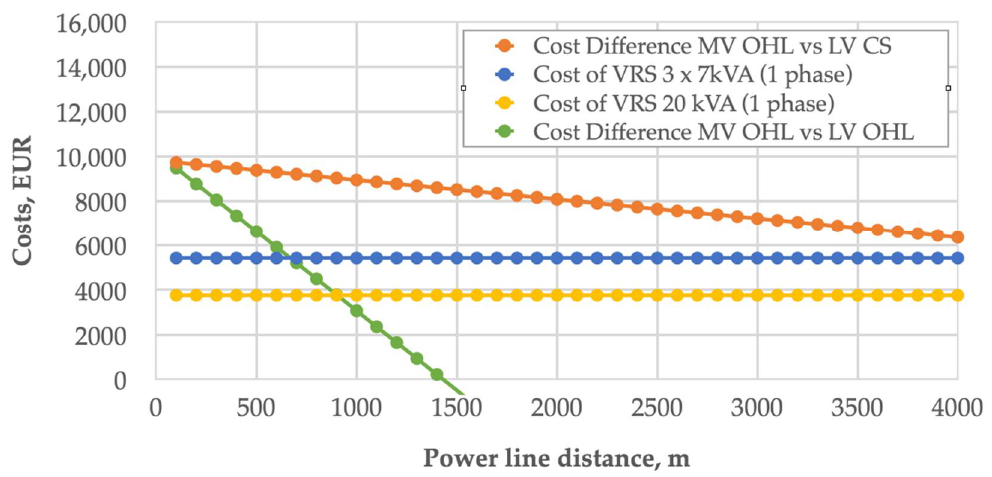
Figure 4. Difference between the line renovation costs vs. voltage stabiliser (VS) costs.